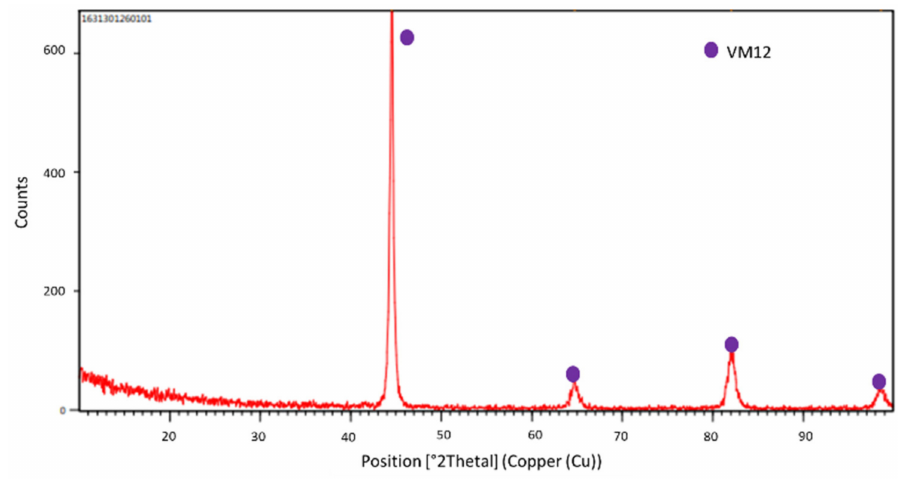
Figure 1. XRD of VM12-SH.